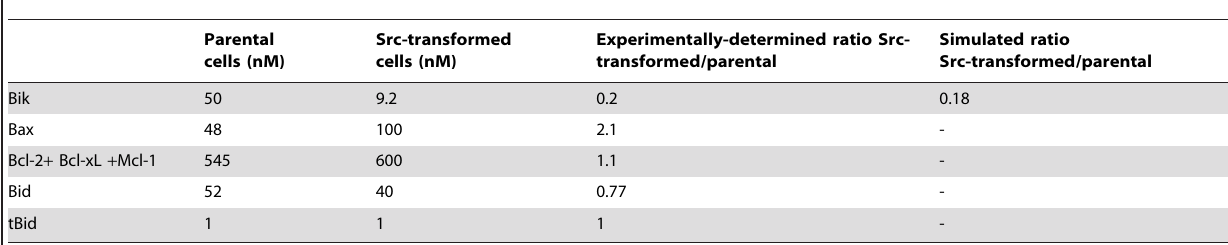
Table 1. Ratios of the different BCL-2 family proteins involved in staurosporine-induced apoptosis.